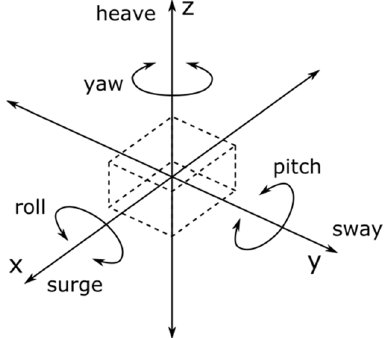
Figure 2. Representation of the degrees of freedom of a floating body.